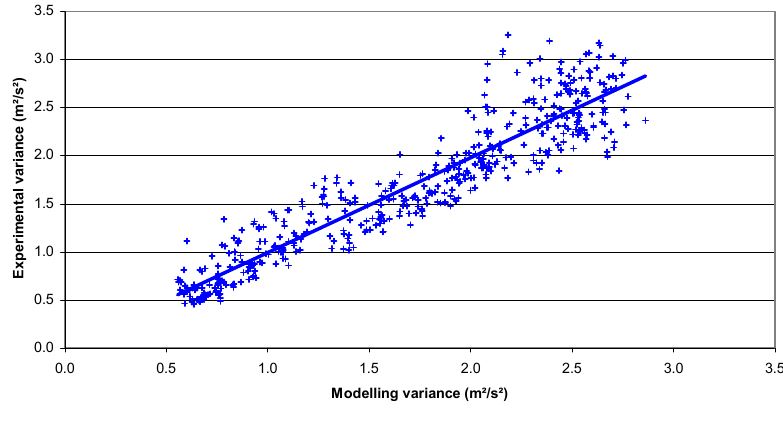
Fig. 5. Comparison between the ex- perimental and the modelled data of the variance (plot CT, level 5, 25 July 1997), y = 0 . 9871 .x + 0 . 0014 ,R 2 = 0 . 8693.